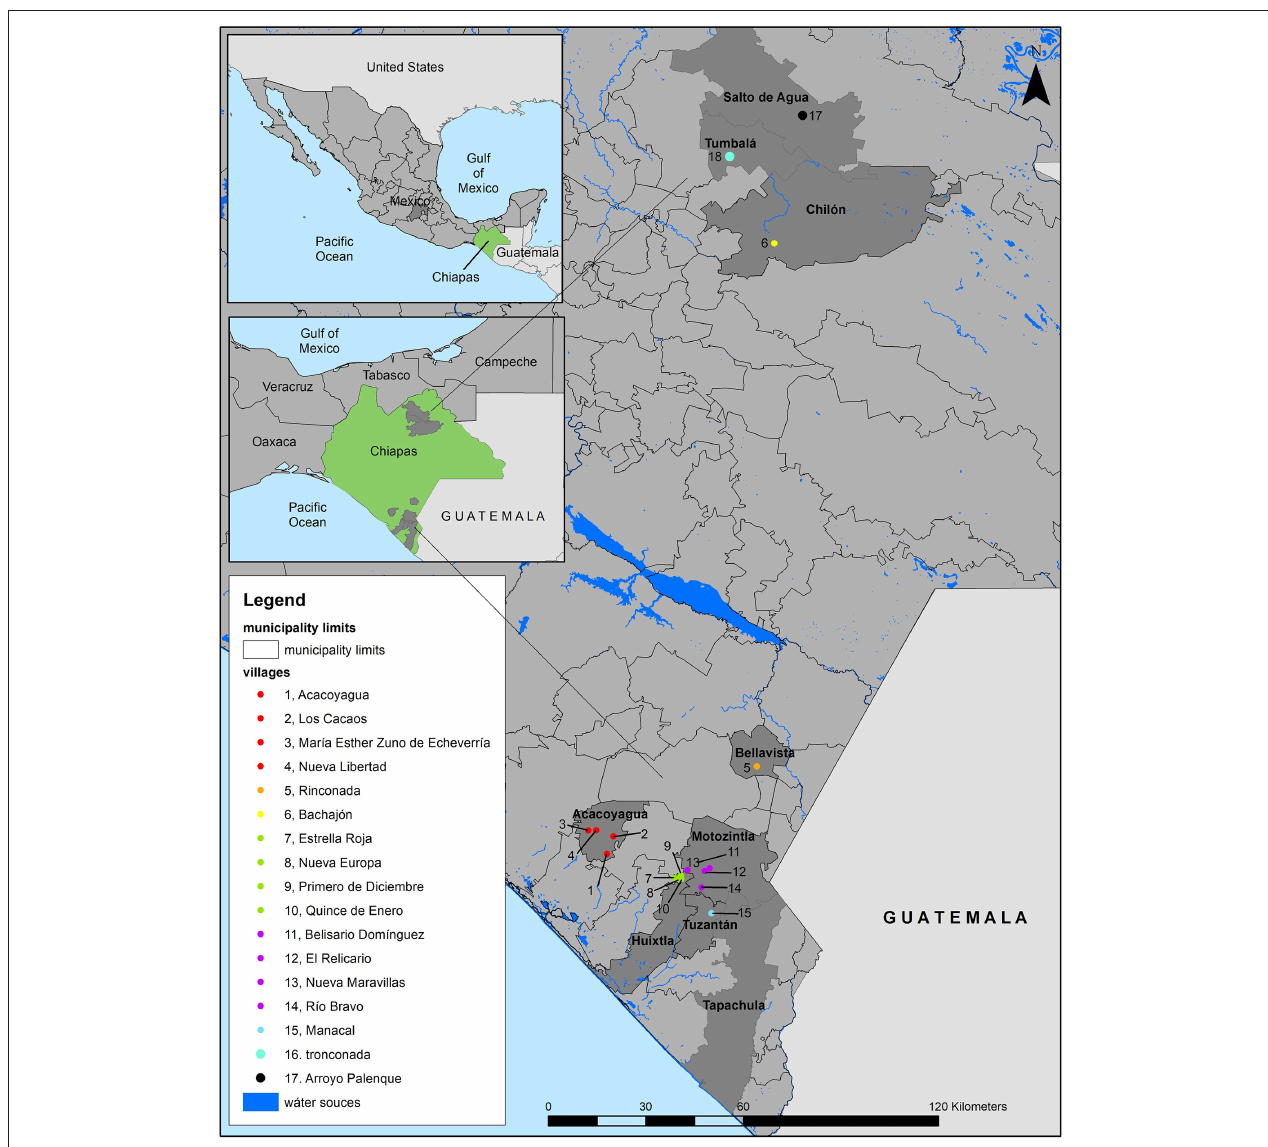
FIGURE 1 | Study area in Chiapas,